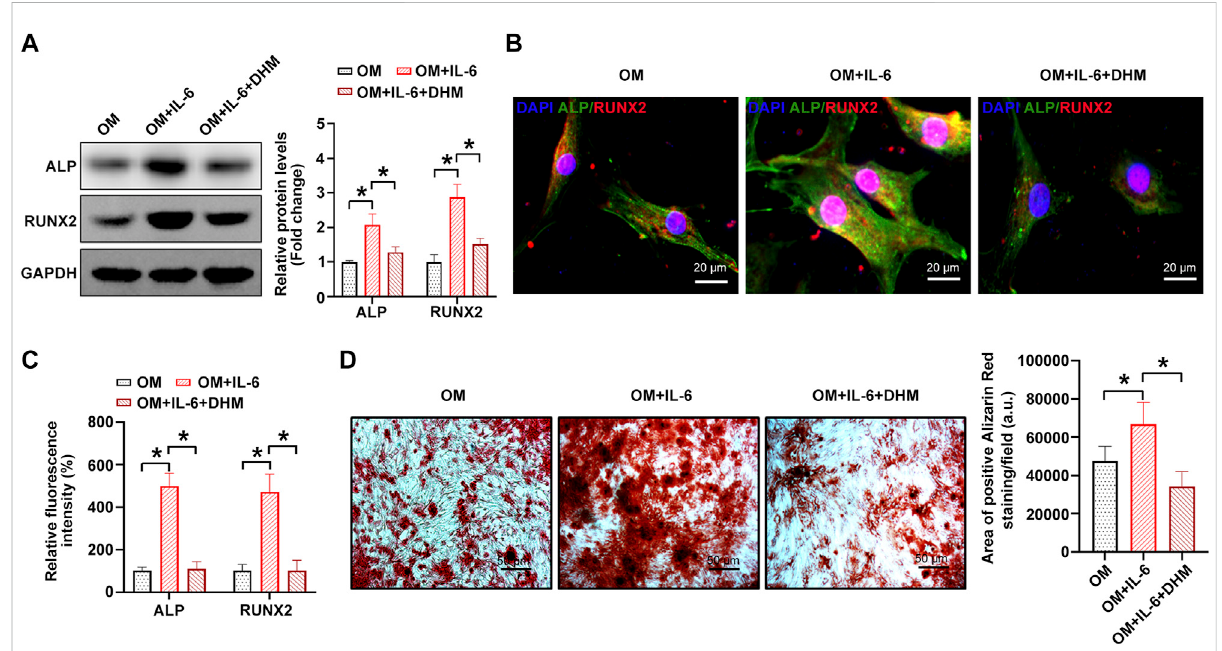
Dihydromyricetin (DHM) rescues the osteogenic differentiation phenotypes induced by interleukin-6 (IL-6) in human valvular interstitial cells (hVICs). Western blotting (A) and immuno fl uorescent staining (B) were used to detect the protein levels of osteogenesis-speci fi c genes (alkaline phosphatase, ALP, and runt-related transcription Factor 2, RUNX2) in hVICs stimulated with osteogenic induction medium (OM) and then cotreated with IL-6or IL-6+DHM.One-way ANOVA followed by Bonferroni posthoc test . (C) Semiquanti fi cationof the fl uorescence intensity of ALPand RUNX2. One-way ANOVA followed by Bonferroni post hoc test . (D) Alizarin red staining of mineralization nodules in hVICs stimulated with OM and then cotreated with IL-6 or IL-6+DHM. One-way ANOVA followed by Bonferroni post hoc test . N = 3 per group. Values are the mean ± SD. * p < 0.05 indicates a signi fi cant